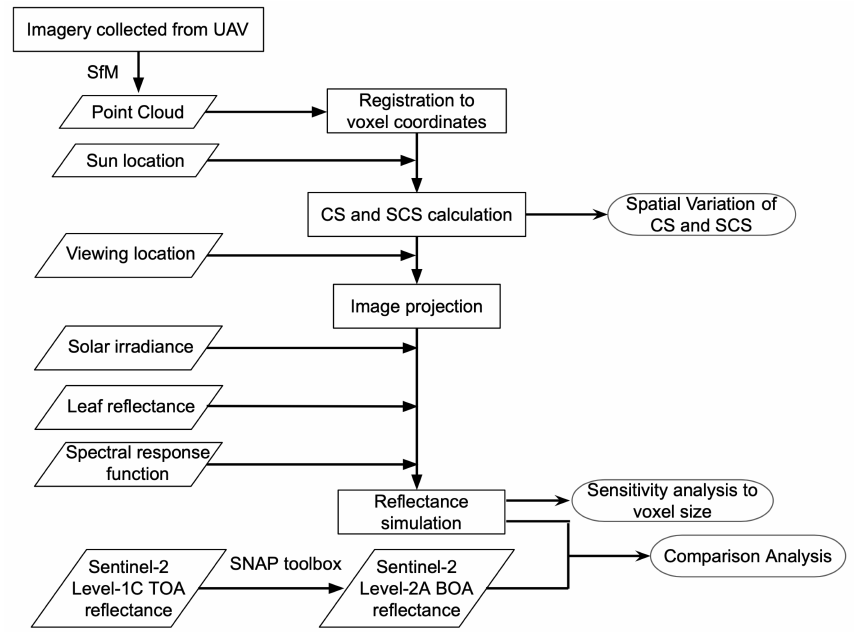
Figure 1. Flowchart of this study. Voxel model was created based on the point cloud and Cast Shadow (CS) and Self Cast Shadow (SCS) were computed as attributes data. The spatial variation of these attributes was calculated with limited view zenith angle and fixed view azimuth angle. The simulated reflectance with shadow parameters was compared with Sentinel-2 BOA reflectance. Finally, the effect of voxel size on simulation result was